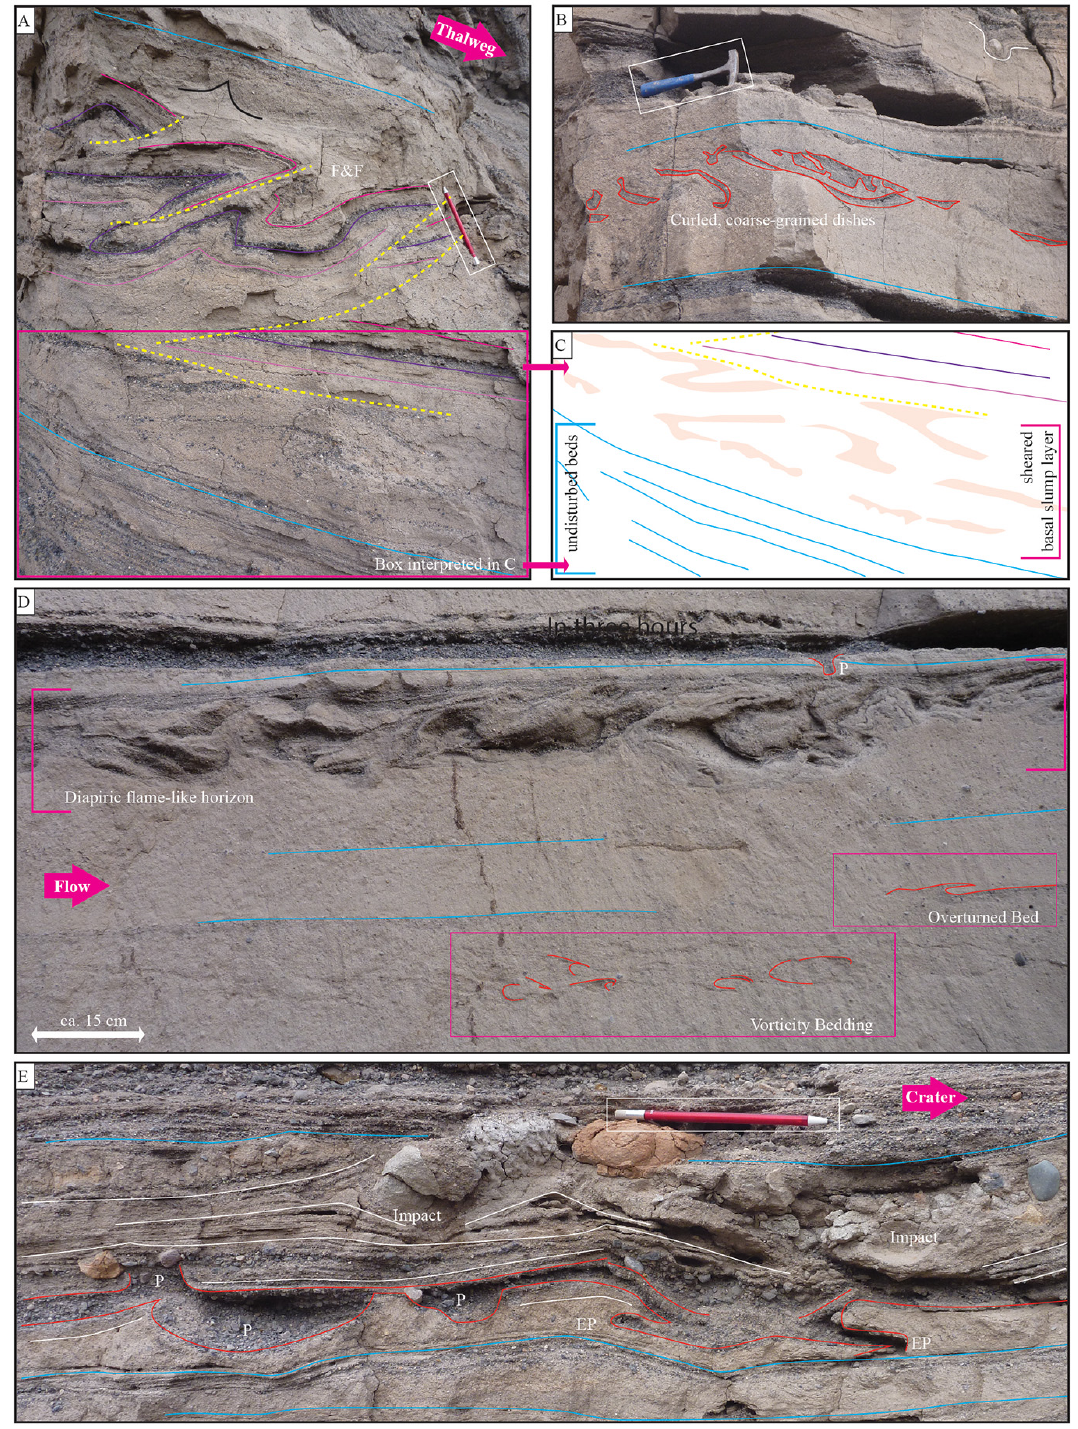
Figure 3. SSD structures from Ubehebe craters. (a) Folds-and-faults structure (F&F) related to slump, with interpretation of the outlined lower part in (c) . (b) Curled and pulled apart coarse-grained dishes interpreted as detached from the above. (d) Diapiric flame-like structures in upper part and a single downward-oriented, attached potatoid (P), recumbent overturned bed in the middle right, vortex beds in the lower part. (e) Interpenetrating coarse bed with potatoids and elongate potatoids (EP) at the base of ballistic impact sags.